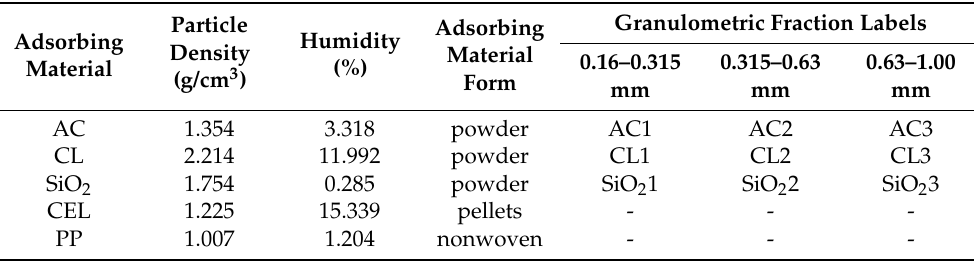
Table 1. Basic information about the adsorbing materials used, such as particle density and material humidity, and its forms and labeling.